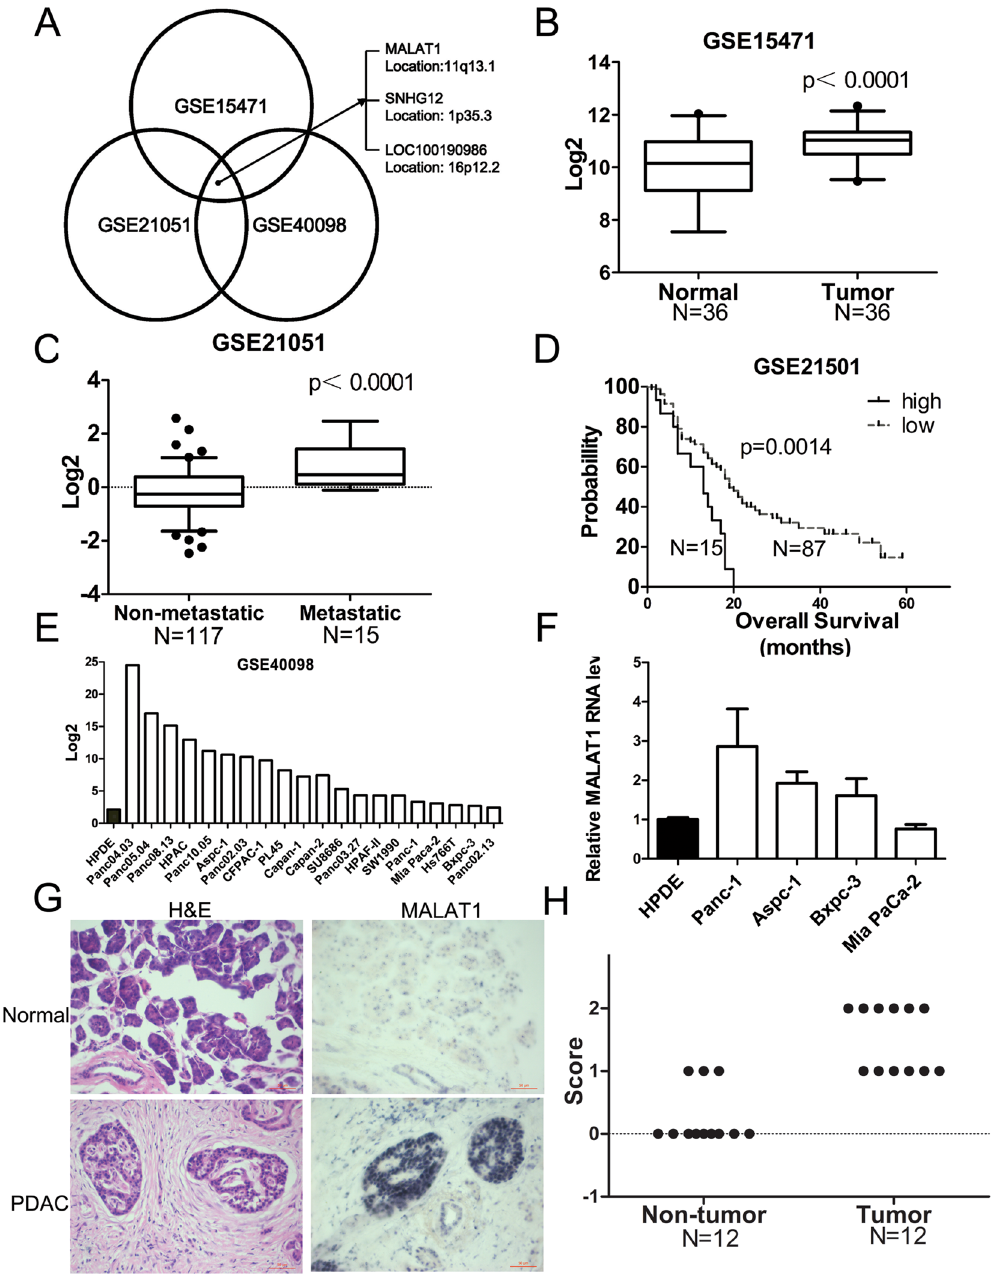
Figure 1. MALAT1 expression and prognostic significance in pancreatic cancer. ( A ) LncRNAs that were overexpressed in all three available sets of gene profiling results and were associated with survival. ( B ) MALAT1 expression in normal pancreatic tissues and pancreatic tumour tissues from patients. ( C ) Relative expression levels of MALAT1 in patients with localized pancreatic tumours and patients with distant metastasis. ( D ) Kaplan–Meier plot showing the survival of patients with pancreatic cancer, according to whether such patients expressed high and low levels of MALAT1. ( E ) MALAT1 expression in pancreatic cancer cells, according to the array data. ( F ) MALAT1 expression in pancreatic cancer cells, as determined by reverse transcription and quantitative real-time PCR. ( G ) MALAT1 expression in normal pancreatic tissues and pancreatic tumour tissues from patients, as determined by in situ hybridization. H&E: Haematoxylin and eosin staining. Bar = 50 μ m. ( H ) Reaction intensity was scored as undetectable or low (0), moderate (1) or strong